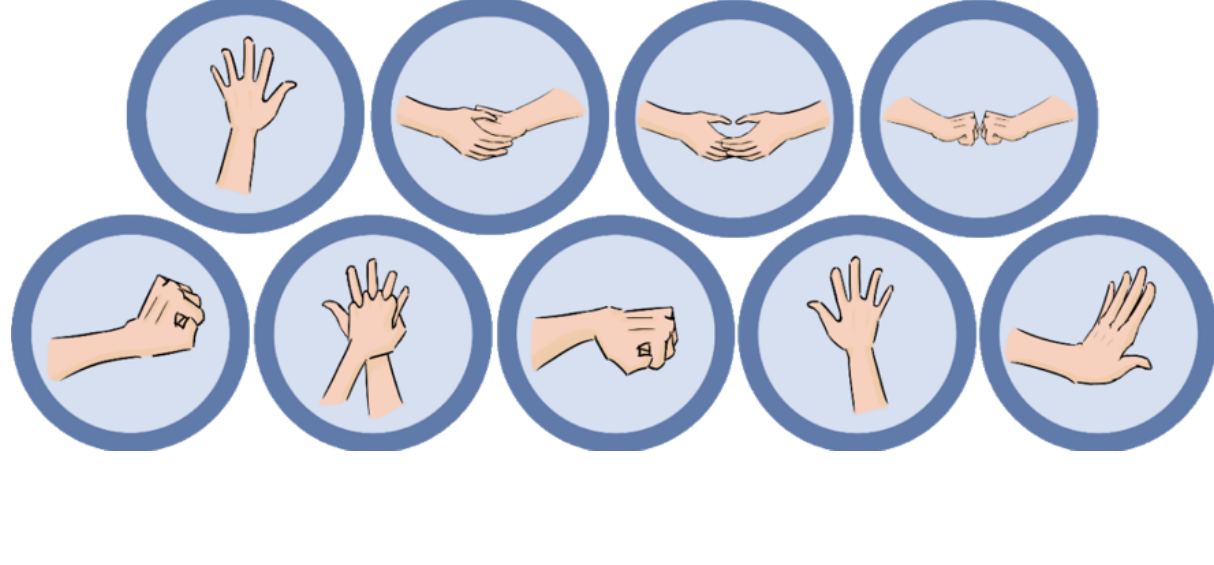
Figure 4. Icons representing different hand